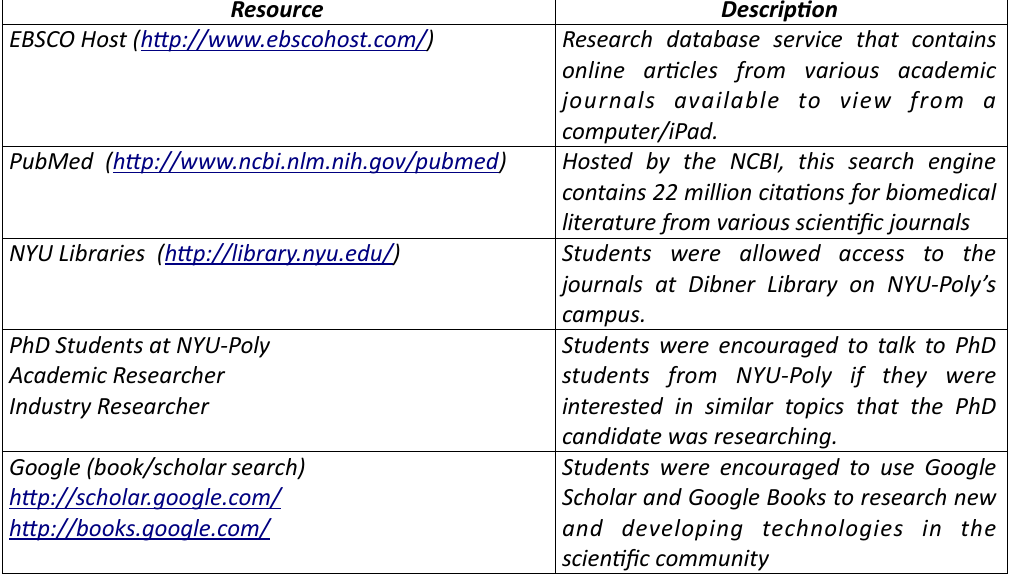
Table 2. Online and Resources Provided to Students for Independent